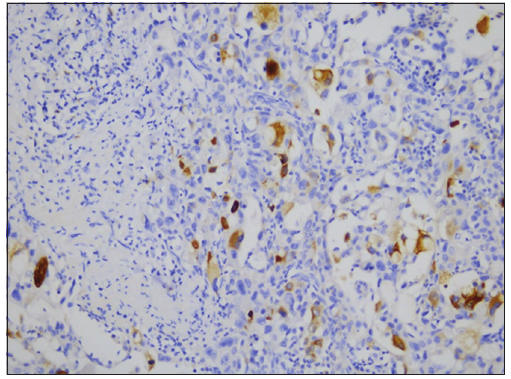
FIGURE 4. Immunohistochemically, the multinucleated choriocar- cinomatous syncytiotrophoblast-like cells, stained with beta-Hu- man Chorionic Gonadotropin antibody (β-hCG), were observed.